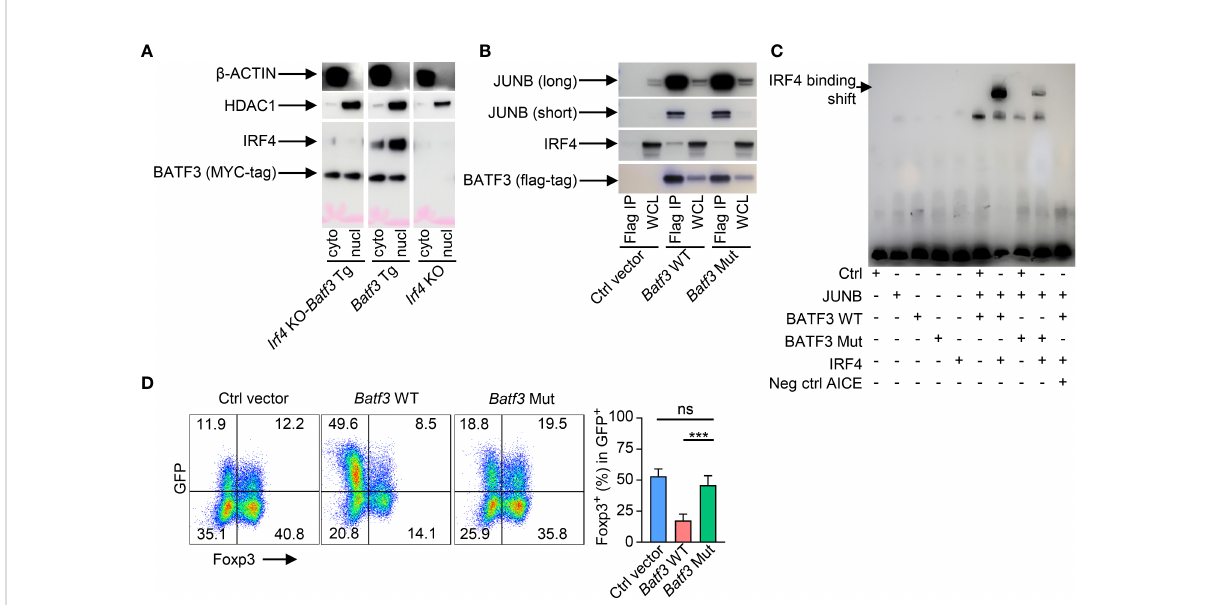
FIGURE 2 BATF3/IRF4 interactions are necessary for BATF3-mediated FOXP3 inhibition. (A) Naïve CD4+ T cells were activated and differentiated in iTreg- inducing conditions. After 48 hours, cells were collected and nuclear and cytoplasmic proteins extracted. Blot representative of 2